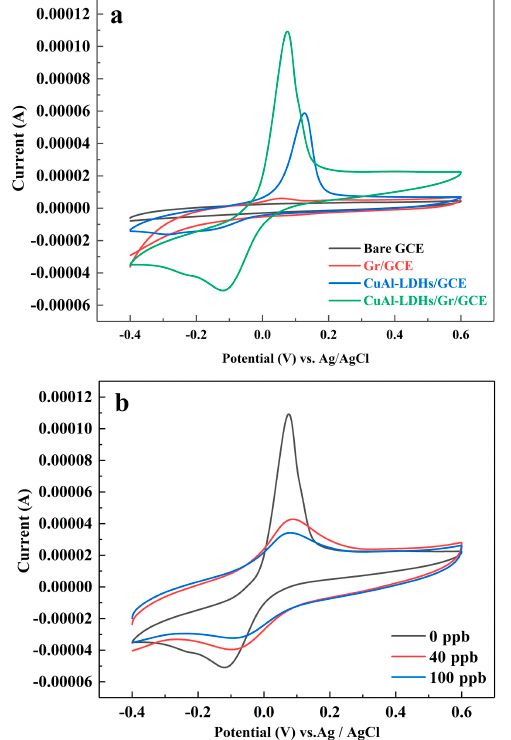
Figure 3. ( a ) Cyclic voltammetry (CV) measurements of the bare electrode, CuAl-LDH, Gr and CuAl-LDH/Gr modified electrodes in BS solution (0.2 M, pH 5.4) and ( b ) CuAl-LDH/Gr/GCE in ABS solution (0.2 M, pH 5.4) with different concentration glyphosate (scan rate 0.05 V/s; sample interval 0.001 V).